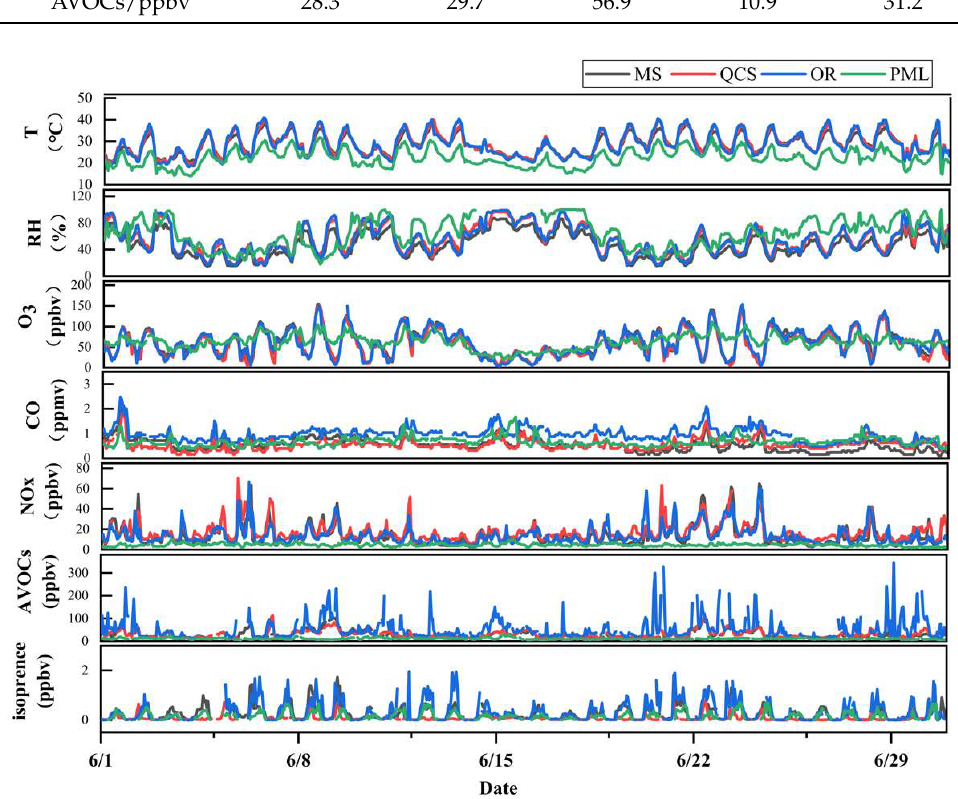
Figure 2. Hourly sequence diagram of meteorological parameters and the pollutant volume fraction at each station over the observation